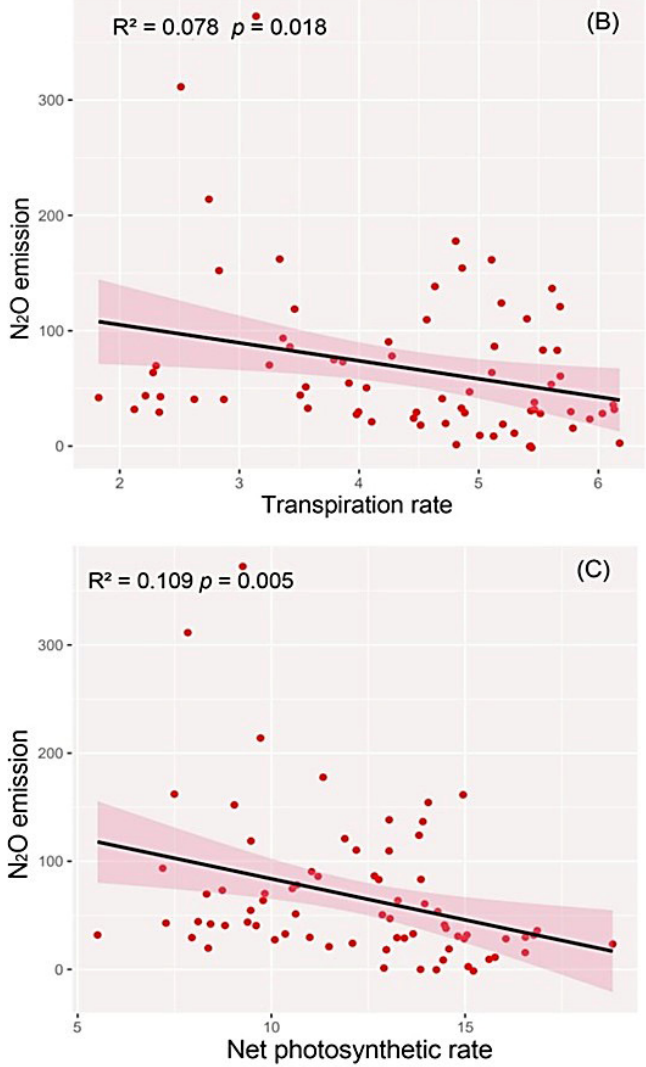
Figure 7. Relationships among the ( A ) Soil organic matter and Root to shoot ratio, ( B ) N 2 O and and Ts, and ( C ) N 2 O and Pn during the experiment. The scattered points represent data measured in each